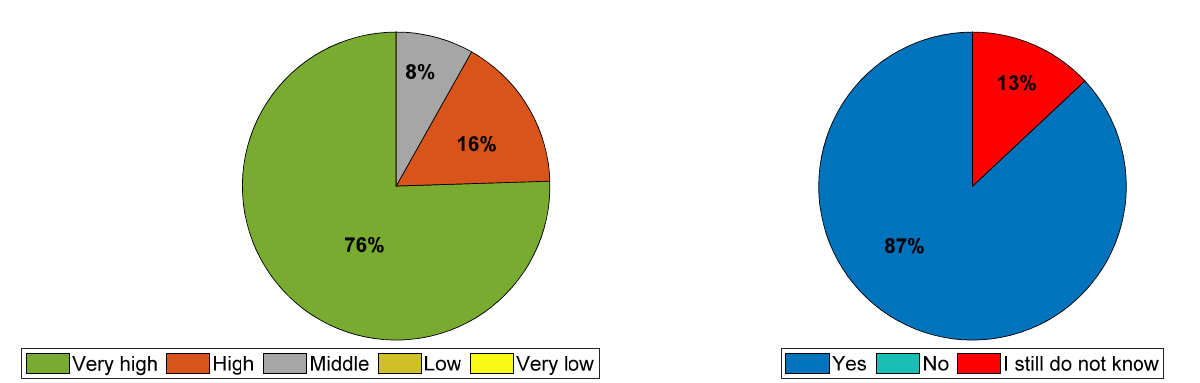
Figure 12. Questions regarding the degree of user satisfaction. ( a ) Tenth question, regarding the acceptance rate. ( b ) Eleventh question, regarding the interest of use.